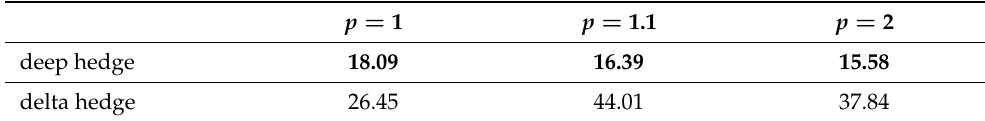
Table 2. Efficient hedging loss for different risk aversion levels with proportional transaction costs of 1%.